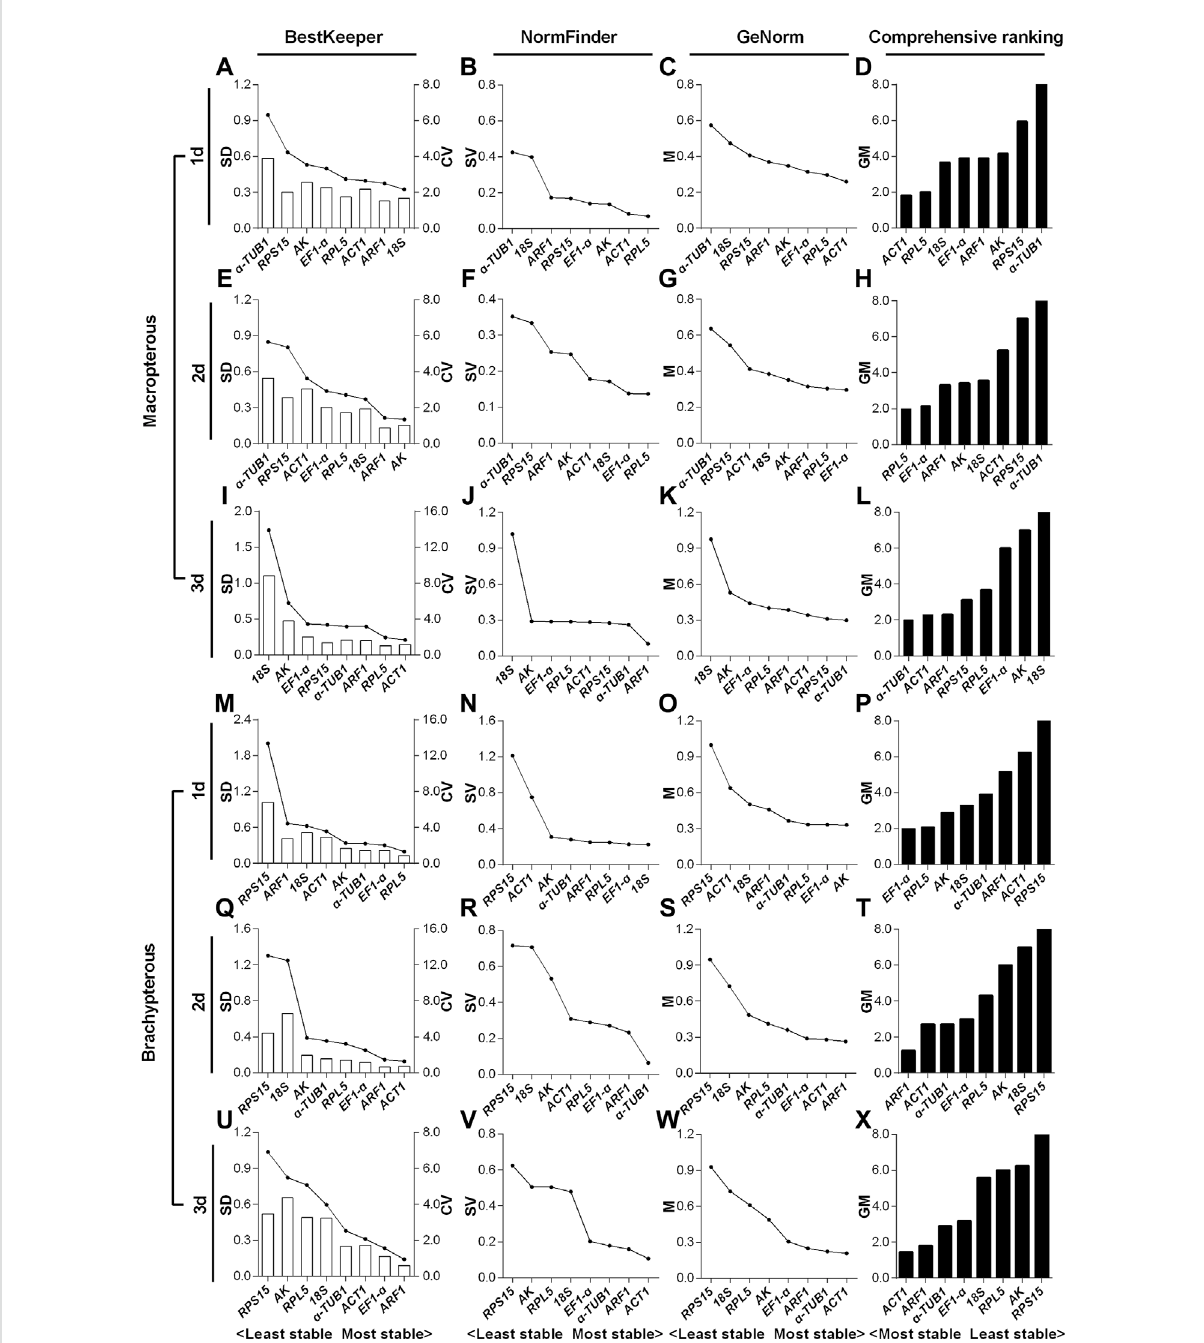
FIGURE 5 Expressionstabilityevaluationofcandidatereferencegenesrespectivelyfor1-to3-day-oldmacropterousandbrachypterousmaleadultsof N. lugens byBestKeeper,NormFinder,GeNormandcomprehensiveanalyses.Eachrowofthepanelindicatesthattheexperimentalsamplesarefrom1- day-old (1d), 2-day-old (2d) and 3-day-old (3d) macropterous [1d, (A – D) ; 2d, (E – H) ; 3d, (I – L) ] and brachypterous [1d, (M – P) ; 2d, (Q – T) ; 3d, (U – X) ] male adults under the hypomagnetic fi eld versus local geomagnetic fi eld. The standard deviation (SD) and coef fi cient of variation (CV) were given by BestKeeper (A,E,I,M,Q,U) . The stability value (SV) was given by NormFinder (B,F,J,N,R,V) . The average expression stability (M) was given by GeNorm (C,G,K,O,S,W) . The comprehensive ranking was further generated based on the results derived from the geometric mean (GM) of these three algorithms (D,H,L,P,T,X) . Stable reference genes generally have lower SD, SV, M and GM